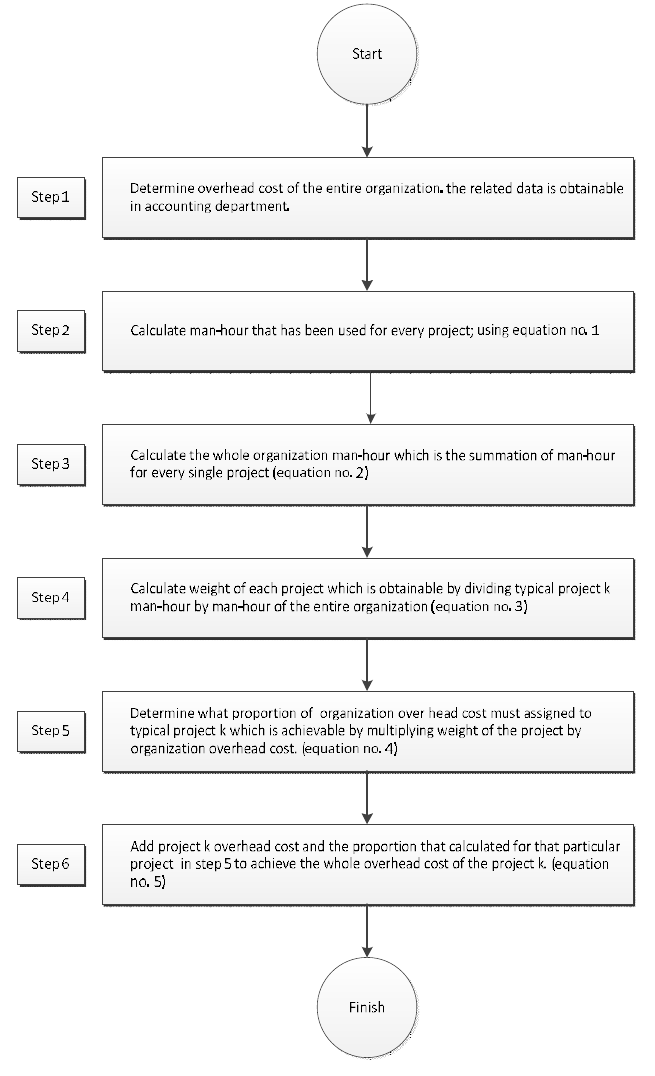
Fig. 2. Step by step instruction of company’s overhead